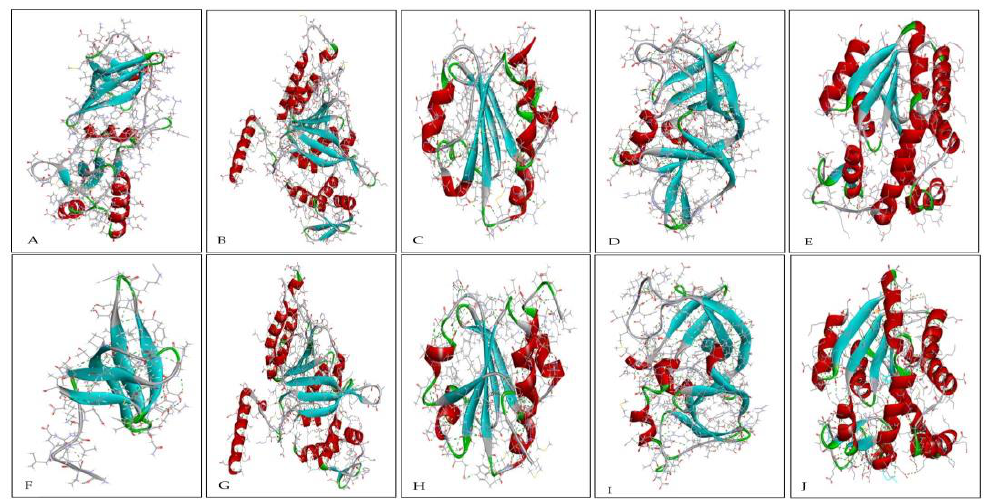
Figure 4. ( A – E ) show the structure of thermophilic protein transcription antitermination protein NusG, protein RecA, thioredoxin, chemotaxis protein CheW, and adenylate kinase, respectively. ( F – J ) shows the structure of their non-thermophilic orthologs, respectively. Coil structure is shown in gray, helix in red, sheet in blue, and turn in green. Conventional hydrogen bonds are represented by the dotted green line, carbon-hydrogen bonds by the light green dotted line, and salt bridges by the dotted yellow line.